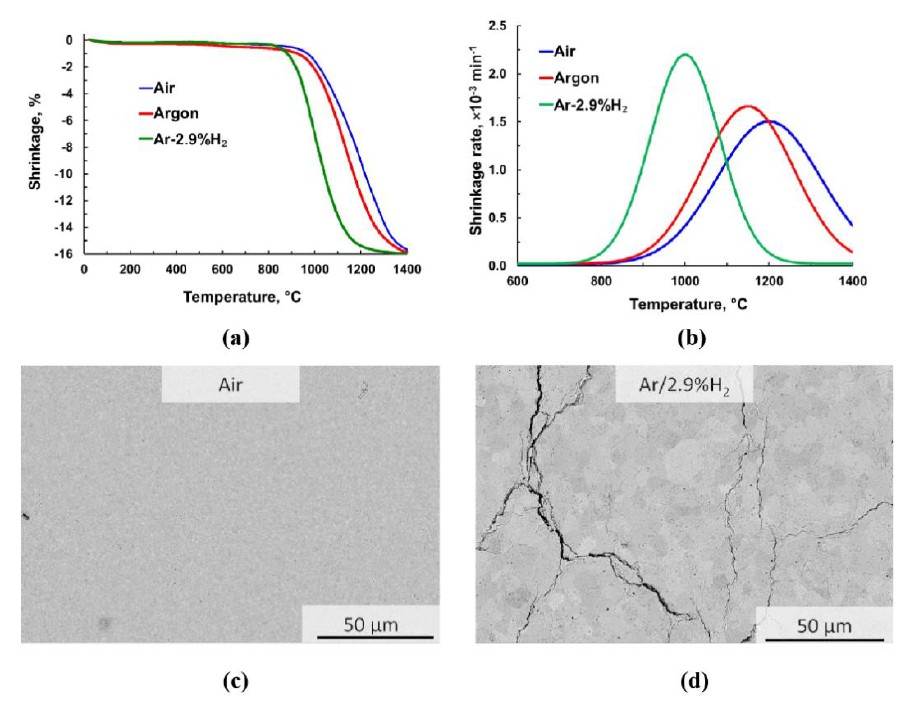
Figure 3. ( a ) Shrinkage of GDC10-HP samples during free sintering in di ff erent atmospheres; Figure 3. (a) Shrinkage of GDC10-HP samples during free sintering in different atmospheres; (b) ( b ) associated shrinkage rate; microstructure of GDC10-HP sample sintered ( c ) in air and ( d ) in associated shrinkage rate; microstructure of GDC10-HP sample sintered (c) in air and (d) in Ar-2.9%H 2 Ar-2.9%H 2 .